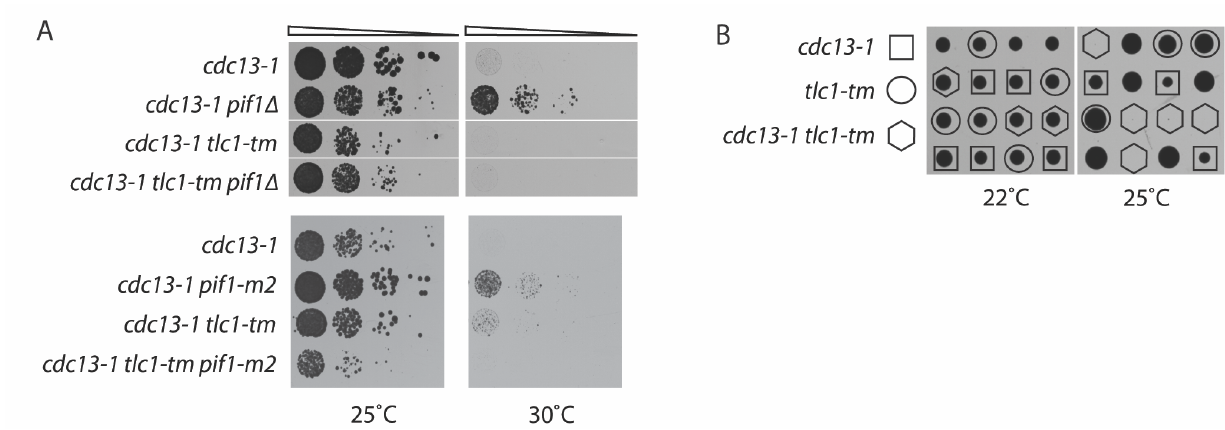
FIGURE 2: Deletion of PIF1 does not rescue telomere capping-deficient tlc1-tm cells. (A) Tenfold serial dilutions of strains with the indi- cated genotypes were spotted on YPD plates and grown at 25ºC or 30ºC. (B) A cdc13-1/CDC13 tlc1-tm/TLC1 diploid strain was sporulated and the resulting tetrads were dissected on YPD plates, which were incubated at 22ºC or 25ºC. Each column of colonies arose from a single